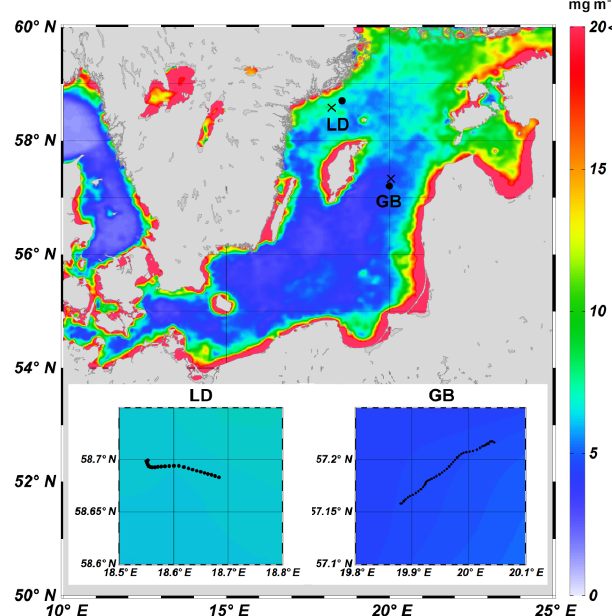
Figure 1. Monthly averaged Chl a distribution derived from VIIRS for June 2015 in the Baltic Sea. Black circle and “x” indicate the position of the trap deployment and the seawater collection, respec- tively, in Gotland Basin (GB) and Landsort Deep (LD). The lower panel shows the trajectory of the trap deployed at GB and